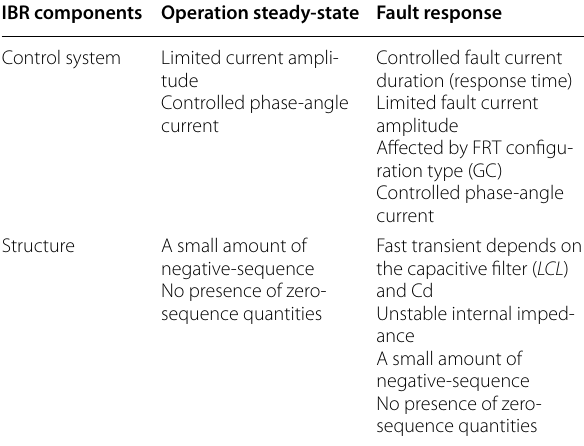
Table 1 Operating characteristics of IBRs IBR components Operation steady-state Fault response Control system